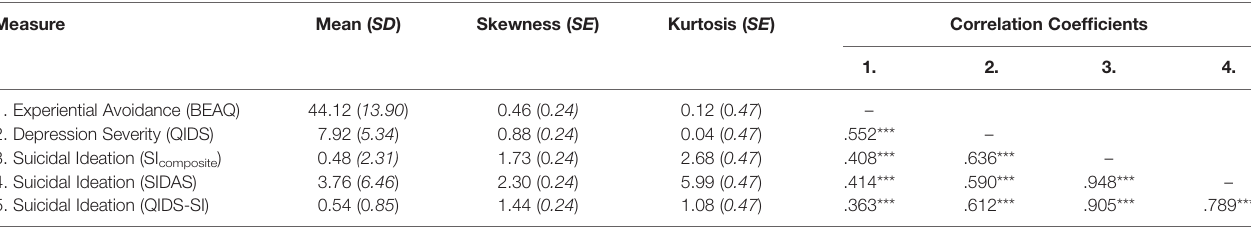
TABLE 2 | Study 1: Means, standard deviations, and correlation coef fi cients for baseline measures.